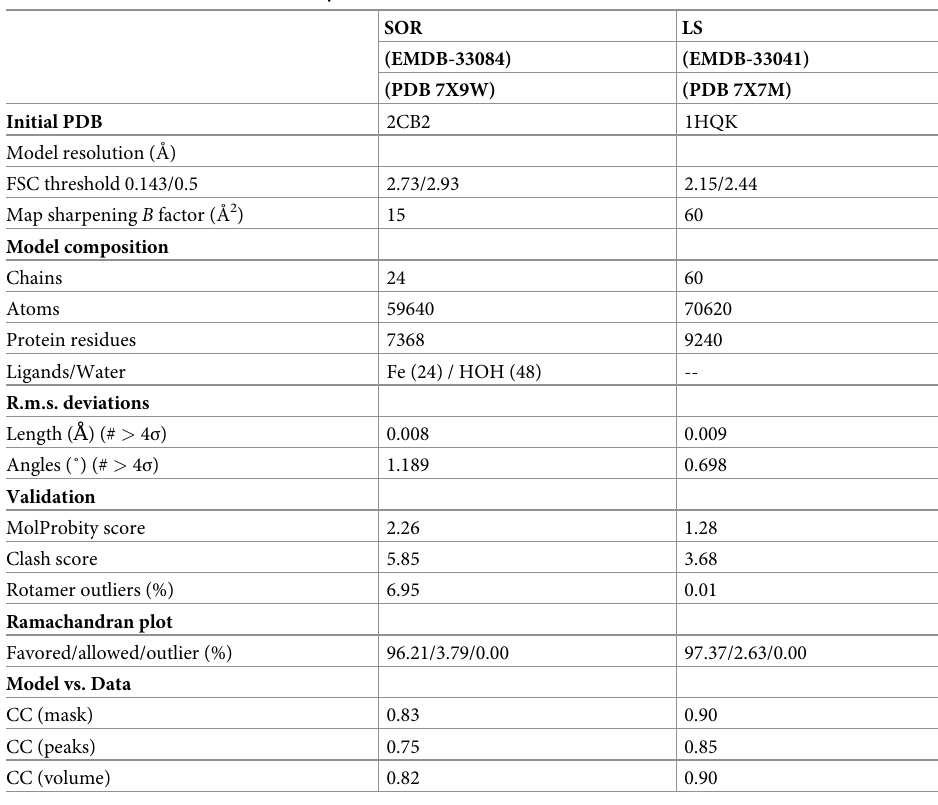
Table 2. Refinement statistics of the cryo-EM